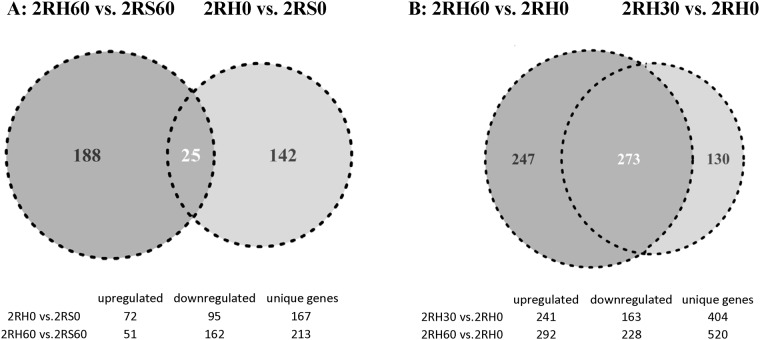
Venn diagrams of differentially expressed genes.A) Comparative analysis of DEGs in the 2RH0 and 2RH60 groups vs their respective saline controls (2RS0 and 2RS60); B) Comparative analysis of DEGs in 2RH groups—2RH30 and 2RH60 vs 2RHO respectively.